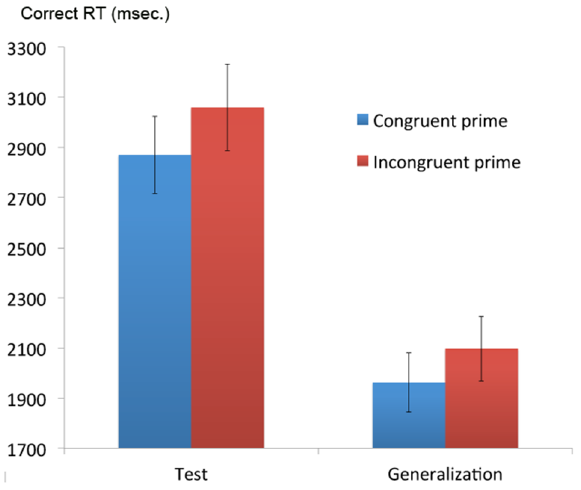
Figure 2. Mean correct reaction times (msec. + / 2 standard error) by prime-task congruency in the Test and Generalization Phases.